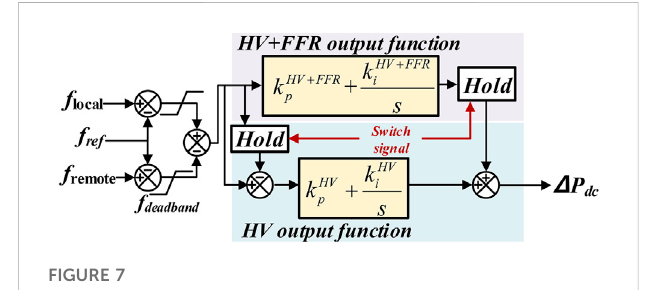
FIGURE 7 Flowchart of the HVDC emergency support control.